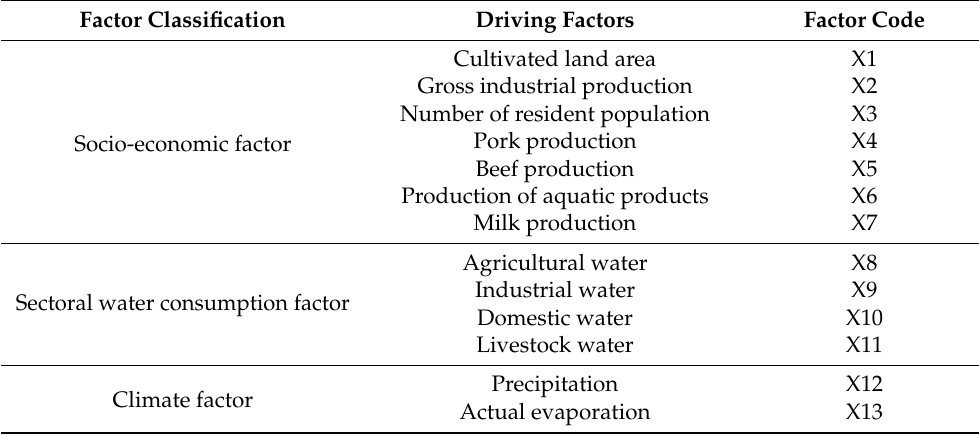
Table 2. Geodetector driving factors and